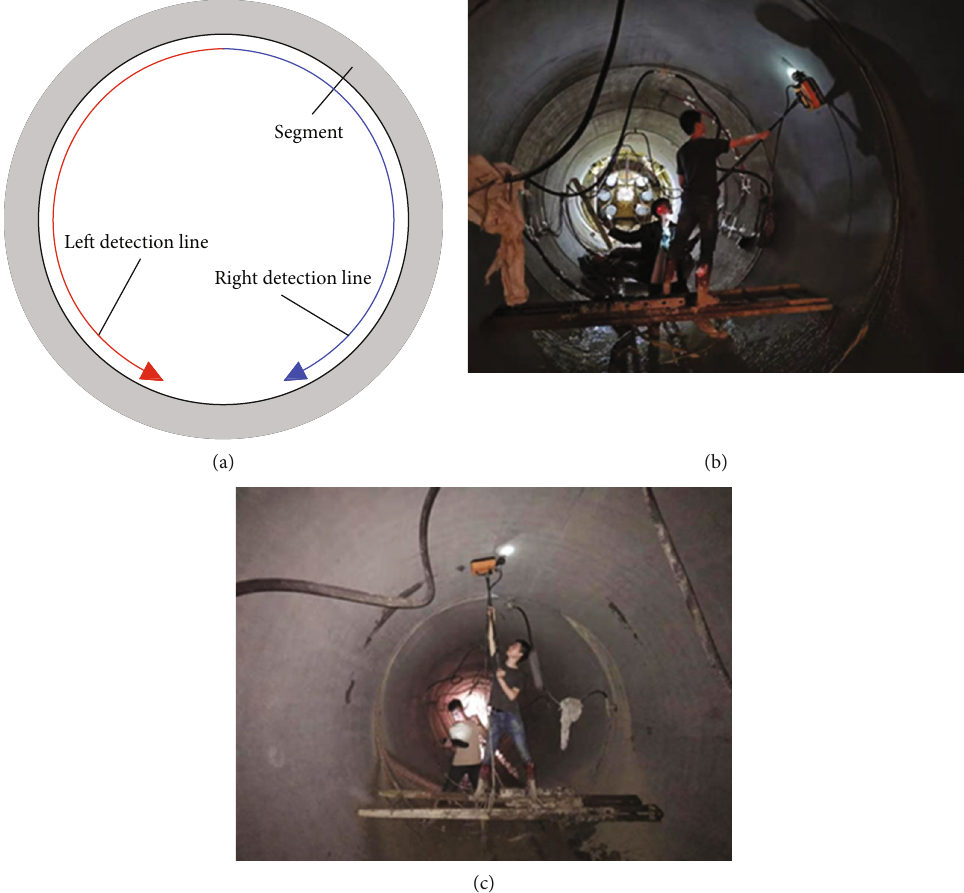
Figure 8: Geological radar detection design and data acquisition. (a) Design drawing of detection circuit. (b) Acquisition the right line. (c) Acquisition the left